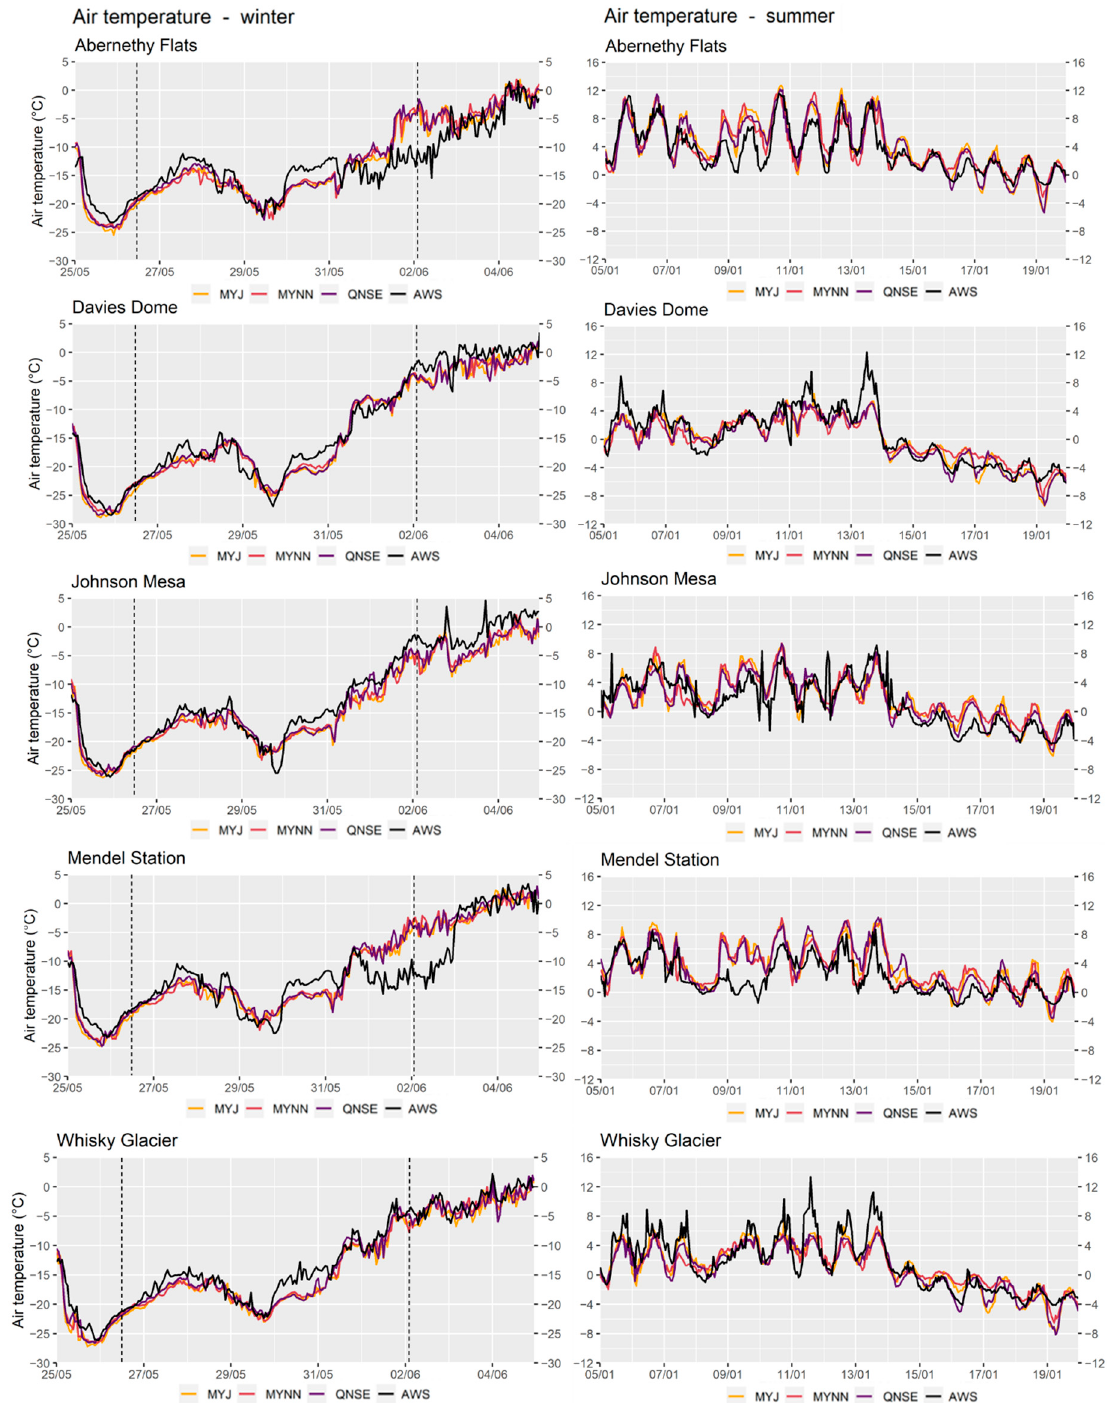
Figure 2. Time series of hourly observed air temperatures at selected automatic weather stations on Ulu Peninsula in winter period ( left ) and summer period ( right ) compared with the corresponding WRF model outputs for three boundary layer schemes (MYJ, MYNN, QNSE). The dashed vertical lines represent time steps described in detail in Section 3.5.